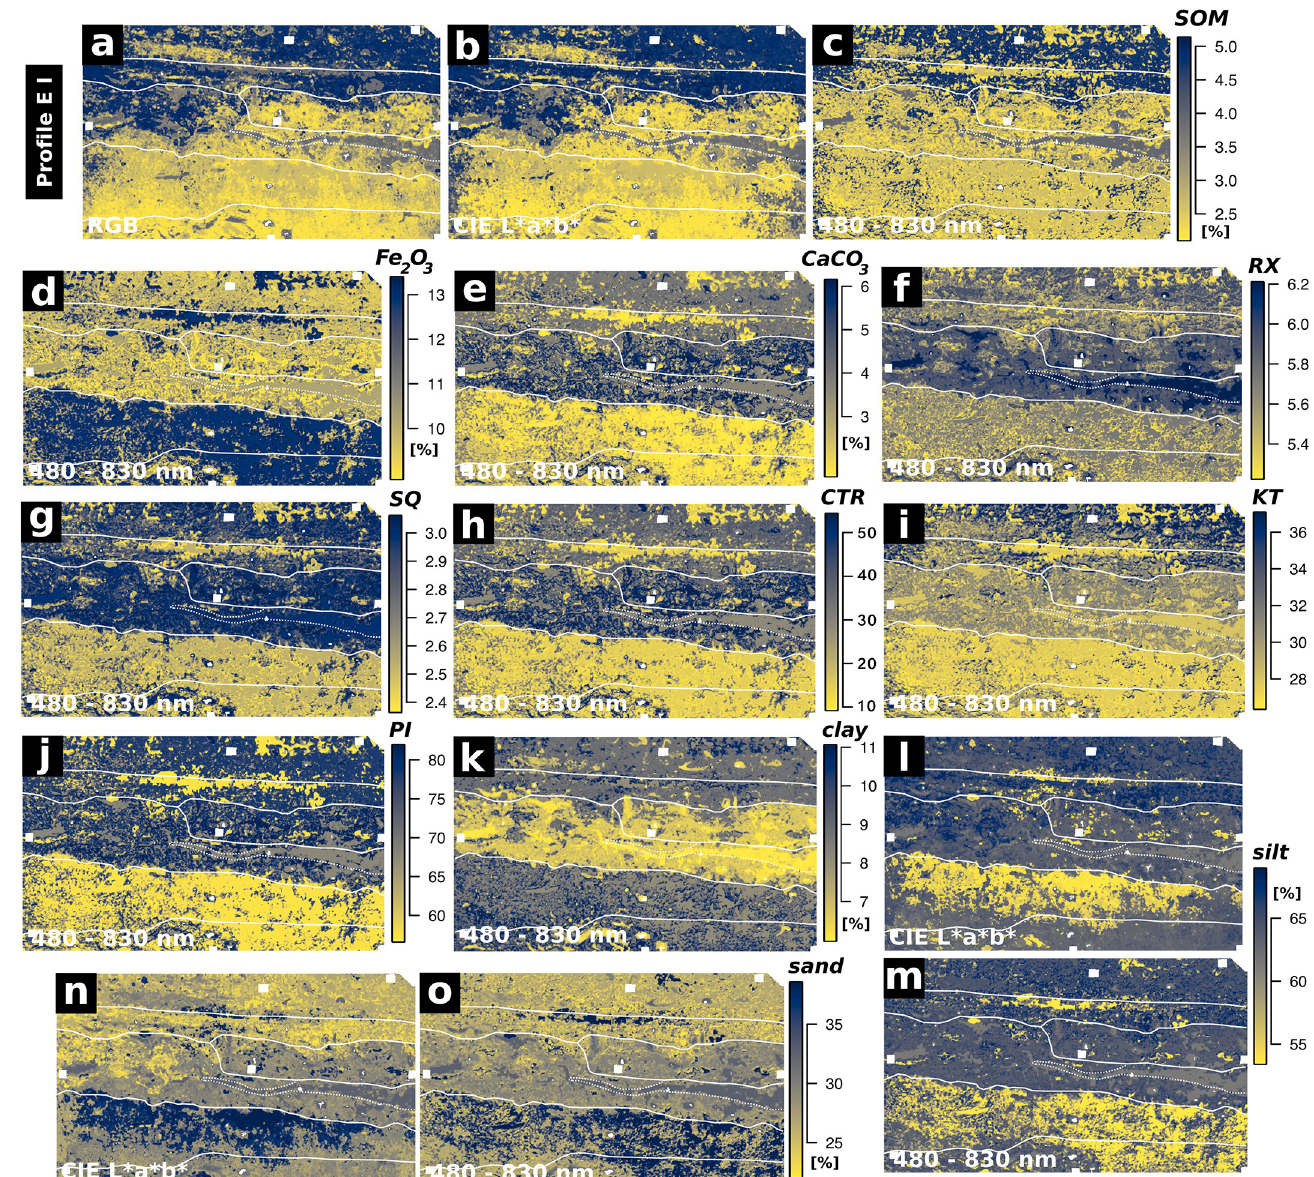
Fig 6. Predicted sediment properties of Profile EI. Only models with a cross-validated R 2 greater than 0.8 and a high correlation between the respective prediction map and the on-site stratigraphic delineation (white lines) are